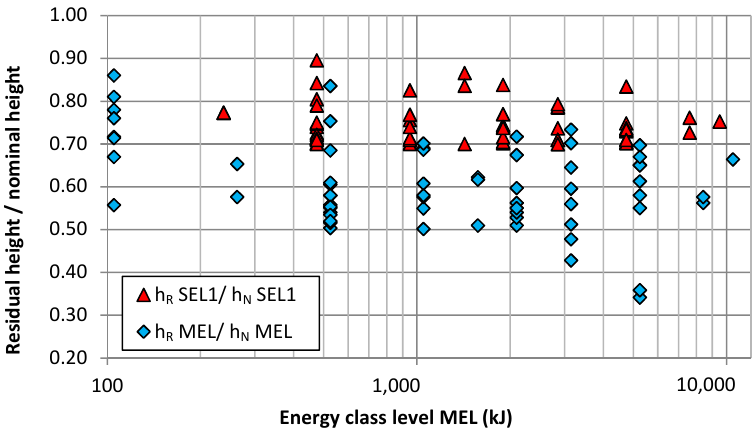
Figure 11. Residual height (h R ) with different colors for SEL1 and MEL tests relative to the measured nominal height (h n ), distributed over the individual energy classes (energy class >4500 kJ expanded to show effective impact